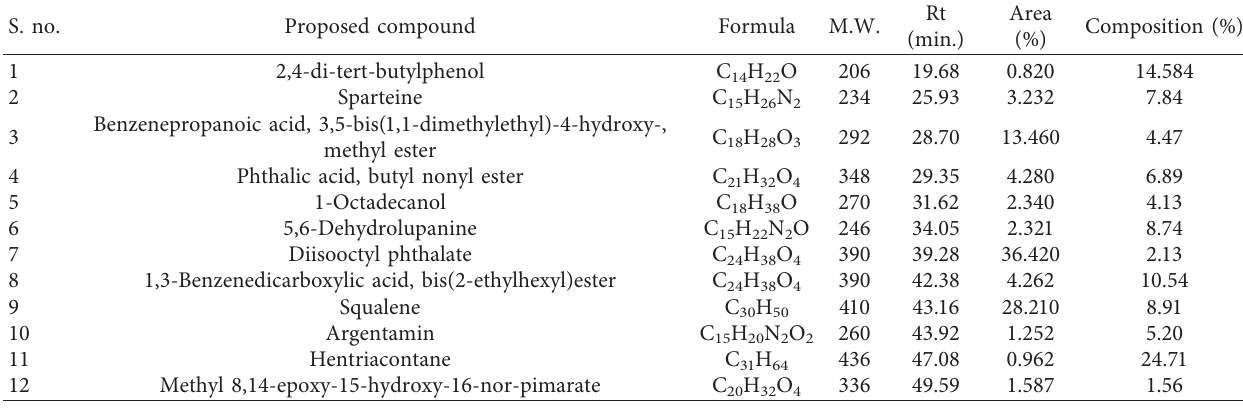
Table 3: Constituents identified in R. raetam plant stem extract by GC-MS.